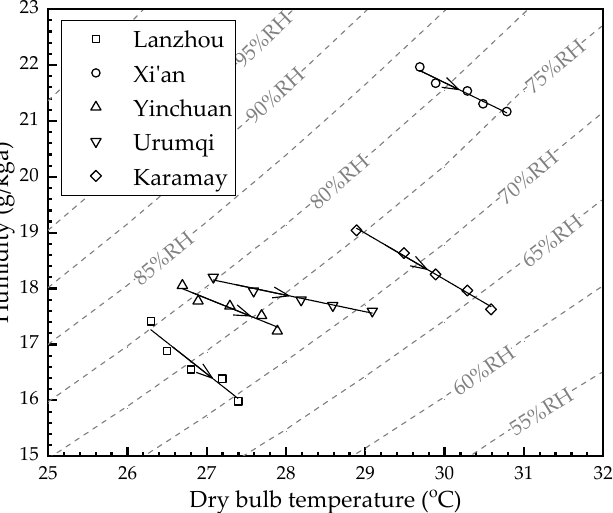
Figure 5. The air outlet parameters of the HFMEC in each city under different air flow rates.